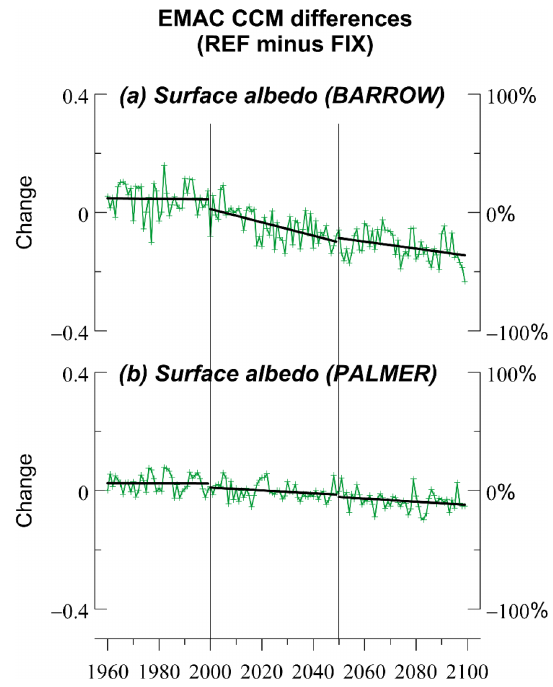
Figure 7. (a) Changes in surface albedo at Barrow, Alaska, and (b) at Palmer, Antarctica, derived from the differences between the two model simulations: the one with increasing GHGs (REF) and the one with fixed GHGs (FIX). Results refer to the summer sea- son. Data were de-seasonalized with respect to the period 1990– 2019 and then were averaged from March to September at Barrow and from September to March at Palmer. The left y axis shows the differences in surface albedo values and the right y axis shows the respective differences in percent of the